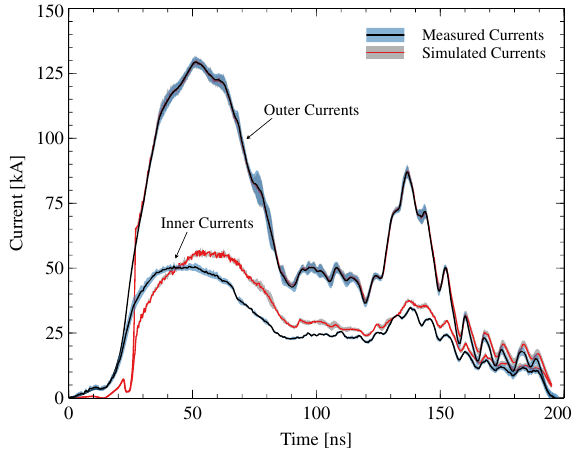
FIG. 4. Comparison of measured and simulated currents. The shaded uncertainty bounds on the “ Case 0 ” simulation are formed using a pair of additional simulations, which are driven to match the mean outer current (cid:2) the uncertainty in the mean U m . Note that the measured and simulated outer currents are nearly indistinguishable for most of the pulse, which shows that the drive pulse used in the simulation was working as